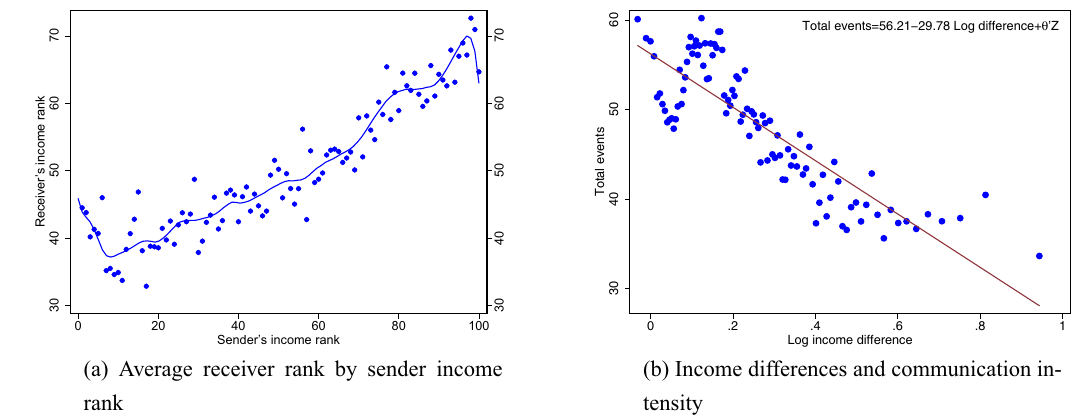
Figure 1. Economic segregation in telecommunication. The figure illustrates economic segregation in telecommunication in Oslo. Panel ( a ) shows the average income rank of receivers by the income percentile of the sender, as well as local linear smoothing of the relationship. Within tower communication is disregarded to exclude within household communication. Panel ( b ) shows a binned scatter plot with the number of communication events between cell phone towers against the absolute value of difference in log income between the two. Z includes controls for geographical distance between two cell towers (up to fourth polynomial), the income level of sending and receiving tower, total tower traffic level and expected tower traffic